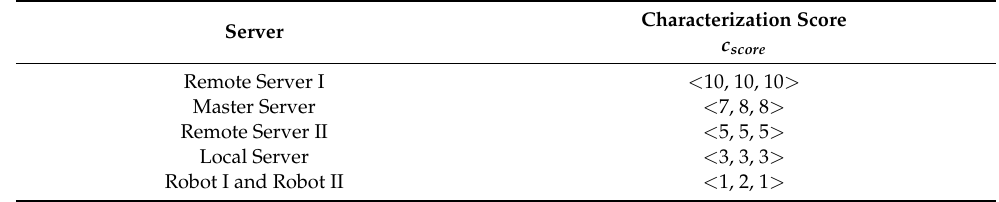
Table 4. Scores for the reference architecture in the motivating